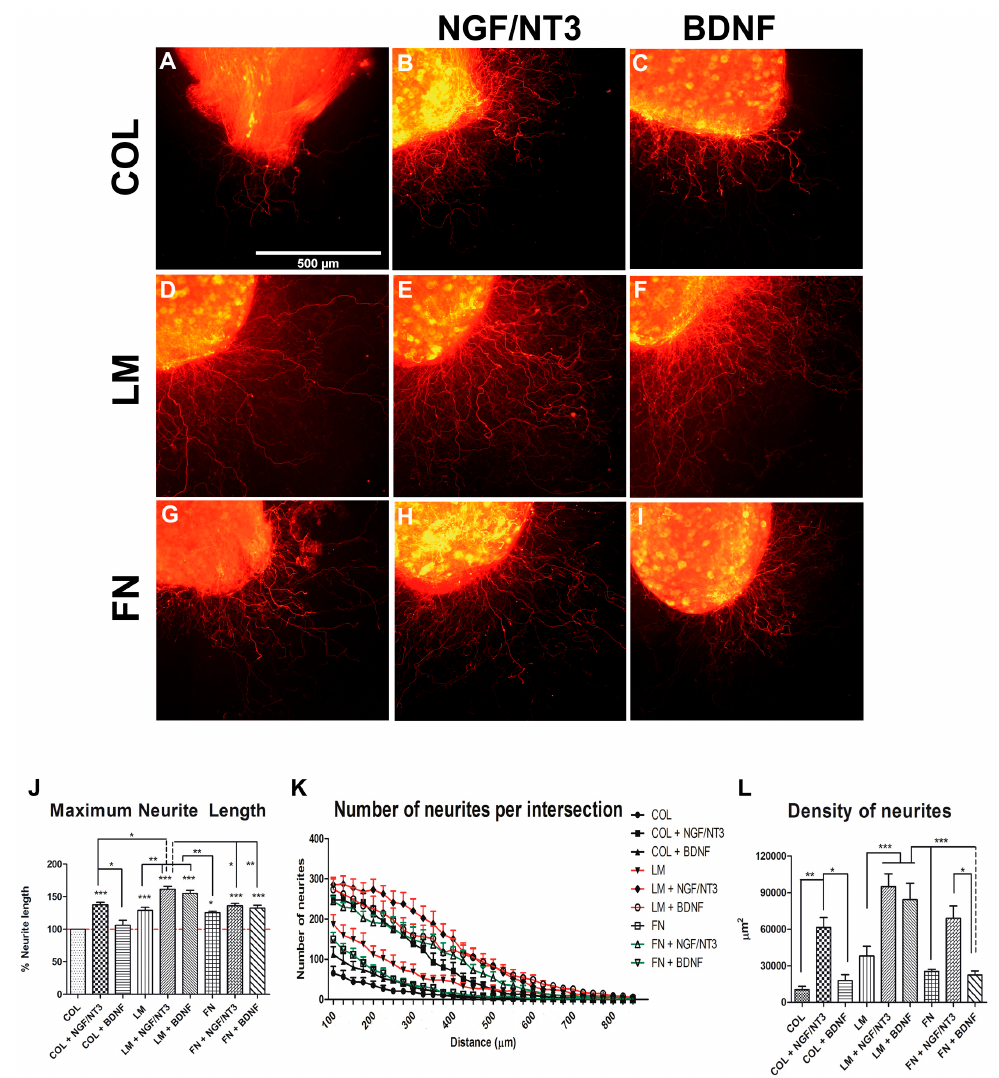
Figure 2. ( A – I ) RT97 stained neurites from DRG neurons cultured within a 3D collagen matrix alone, and with addition of NGF/NT3 or BDNF ( A – C ); with 20% laminin, plus NGF/NT3 or BDNF ( D – F ); and with 20% fibronectin, plus NGF/NT3 or BDNF ( G – I ); ( J ) plots representing maximum neurite length in the different culture conditions, dashed line represents the values for COL control group (100%); ( K ) quantification of the number of neurites grown at increasing distance from the cord slice; and ( L ) plots of the quantified area under each curve of K graph. Data expressed as mean ± SEM. * p < 0.05, ** p < 0.01 and *** p < 0.001.